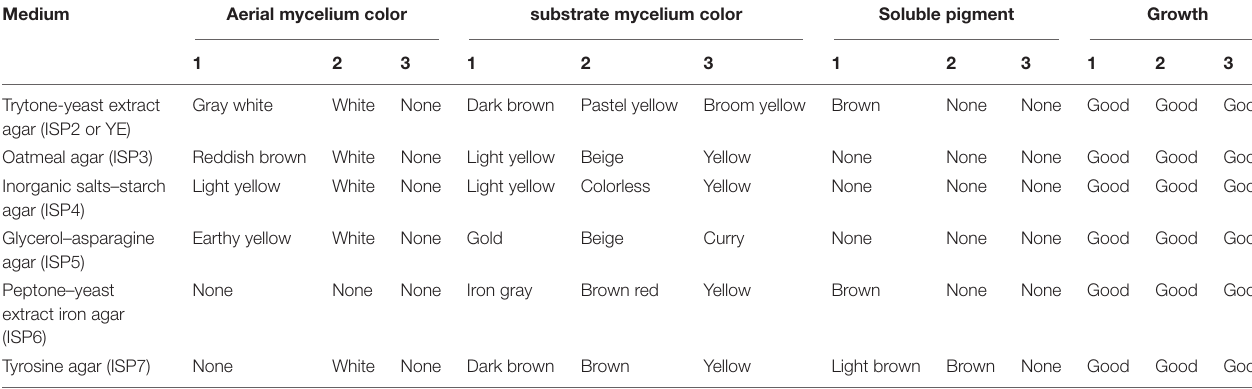
TABLE 1 | Comparison of growth characteristics between strain SCA2-4 T and closely related strains on six standard ISP media.